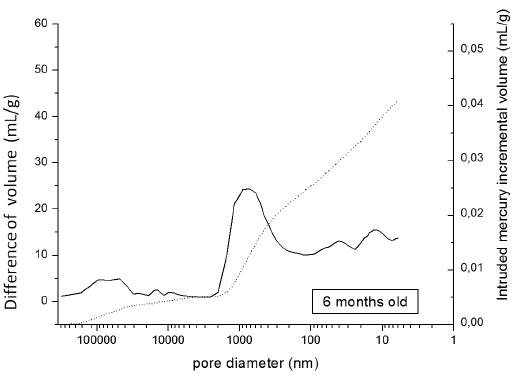
Figure 15. Porosimetry of fiber cement D at 28 days.